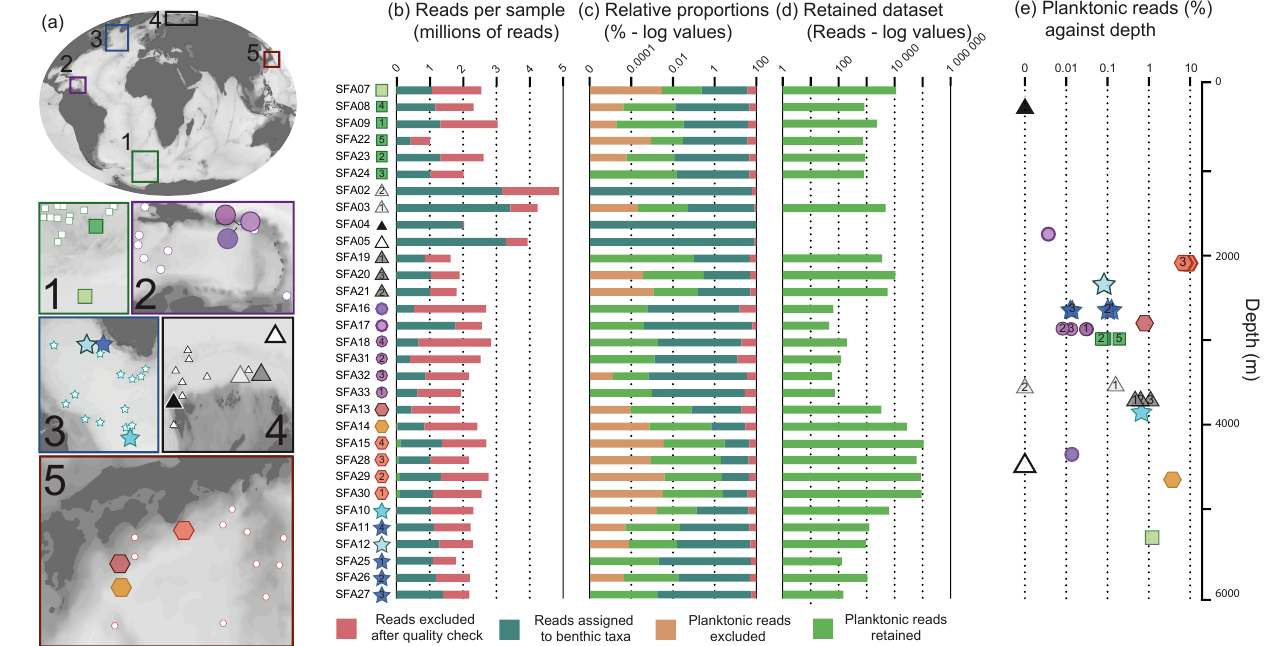
Figure 1. Occurrences of planktonic foraminifera in abyssal sedimentary e DNA. (a) Geographic location of the samples. The boxes indicate the location the core top samples in the five sampled regions. The larger symbols indicate the location of the samples used for e DNA analysis generated by Lecroq et al. (2011) and the smaller open symbol the location of the census count from the MARGO database (Kucera et al., 2005). (b–d) Results of the filtering and assignation of the dataset. The symbols with numbers correspond to the replicates of a single location shown on (a) , next to the library’s name. The replicates are subsamples originating from the same gear (Lecroq et al., 2011). (e) Relative proportions of planktonic reads in the individual samples in logged values plotted against